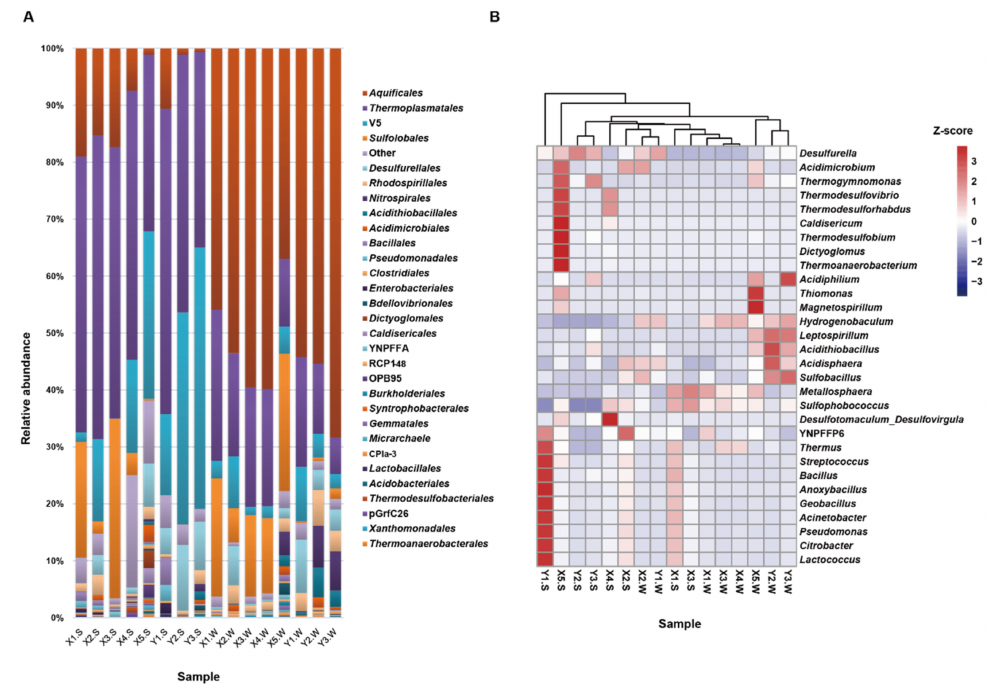
Figure 5. ( A ) Relative abundances of the top 30 most abundant bacterial and archaeal taxa at the order level. ‘Others’ represent all taxa that scored a relative abundance of below 1% across all samples in both data sets. ( B ) Heatmap of Z-score-transformed relative abundances at the genus level. The heatmap scale displays the row Z score (Z score = [actual relative abundance of bacterial taxa at the class level at a specific depth of one sample—mean relative abundance of the same taxa in all samples]/standard deviation). Thus, the positive Z scores in red indicate values above the mean, while the negative Z score values in blue are below the mean in units of standard